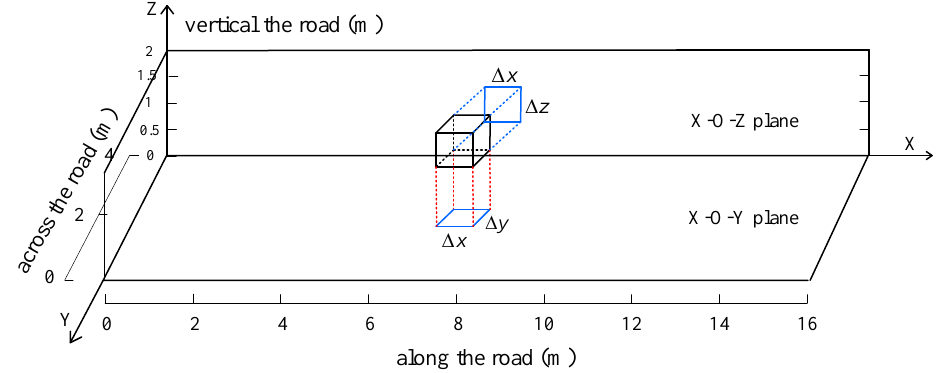
Figure 3. The projection diagram of one voxel on the X-O-Y plane and the X-O-Z